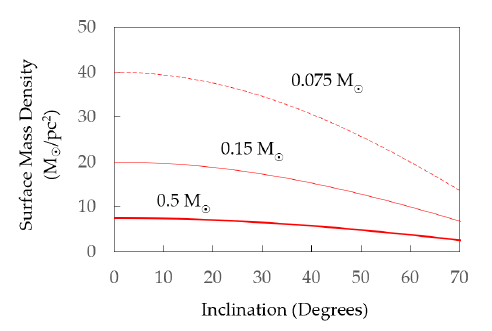
Figure 12. Approximate limits of Spitzer IRAC channel 1 detection (at 27 mag AB / arcsec 2 apparent surface brightness) for stellar populations consisting exclusively of stars with masses 0.075 M (cid:12) , 0.15 M (cid:12) or 0.5 M (cid:12) , expressed in terms of surface mass density (M (cid:12) / pc 2 ). X-Axis shows inclination of galactic disk in degrees. Here, we assume inclination correction C = cos( i ) and use our adopted main-sequence stellar MLR function estimated for Spitzer 3.6 µ m passband (see Appendix B).